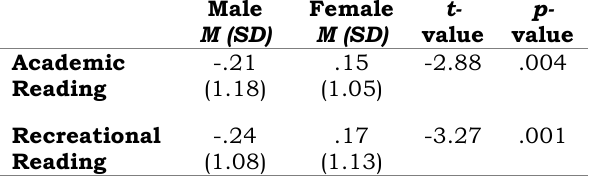
Table 1. Independent Sample t -test Result of Reading Attitude by Gender